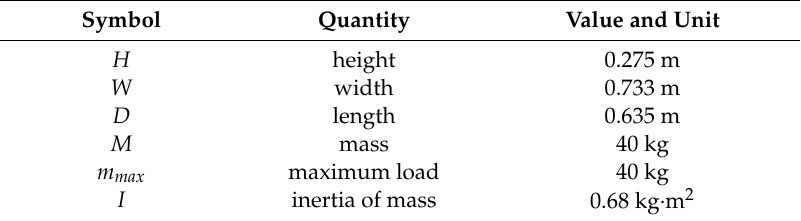
Table 1. Physical Parameters of the wheeled mobile robot.